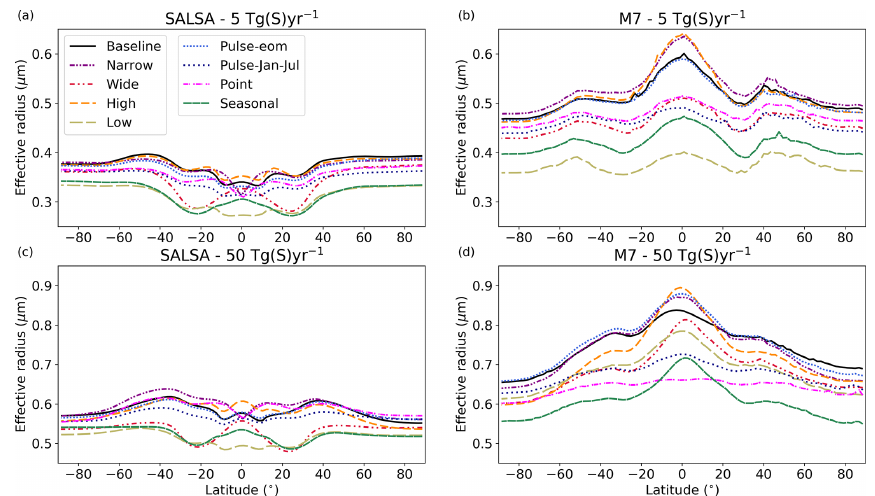
Figure 9. Zonal mean effective radius of stratospheric aerosols in the studied sensitivity scenarios for ( a , b ) 5 and ( c , d ) 50Tg(S)yr − 1 injection rates simulated with (a,c) SALSA and (b,d)